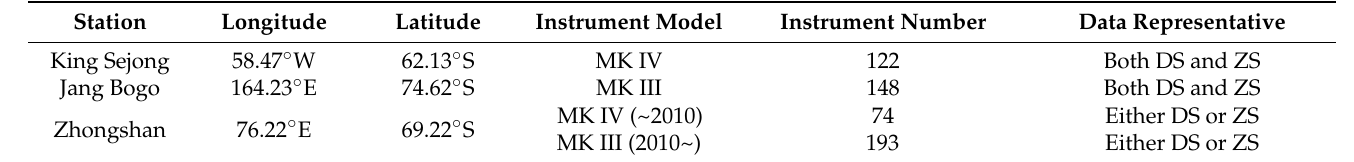
Figure 1. Three Antarctic TOC observation stations used in this study: King Sejong station on King George island (58.47°W, 62.13°S); Jang Bogo station adjacent to the Ross Sea (164.23°E, 74.62°S); and Zhongshan station adjacent to the Indian ocean (76.22°E, 69.22°S). Table 1. Summary of Brewer specifications for each station used in this